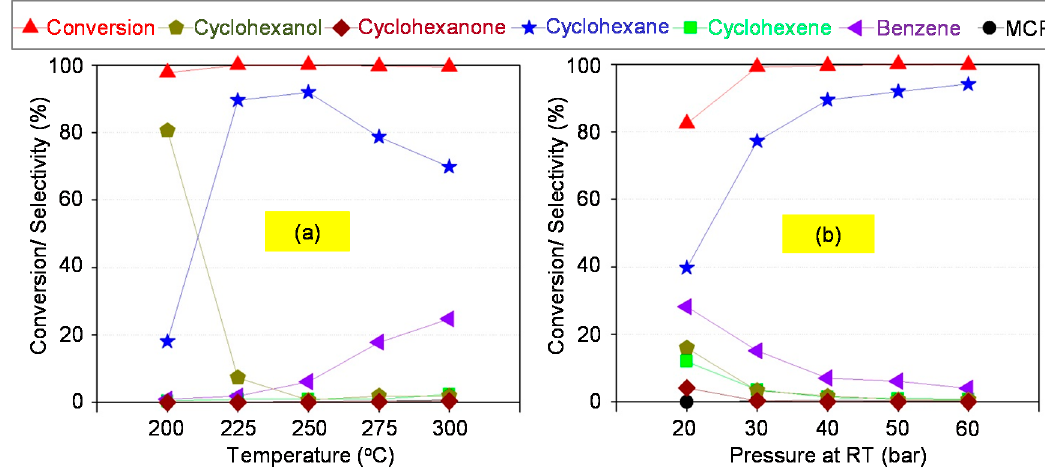
Figure 6. Effect of ( a ) temperature and ( b ) pressure on phenol HDO with 10Ni10Co/HZSM-5 in the batch reactor (5.3 mmol of phenol, 10 g of H 2 O, 25 mg of catalyst, t = 1 h).